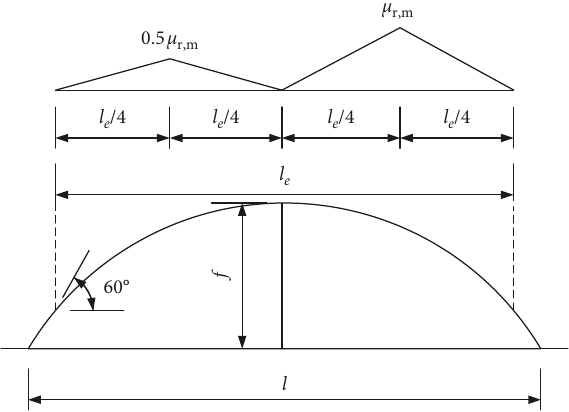
Figure 26: Distribution factor of snow pressure.